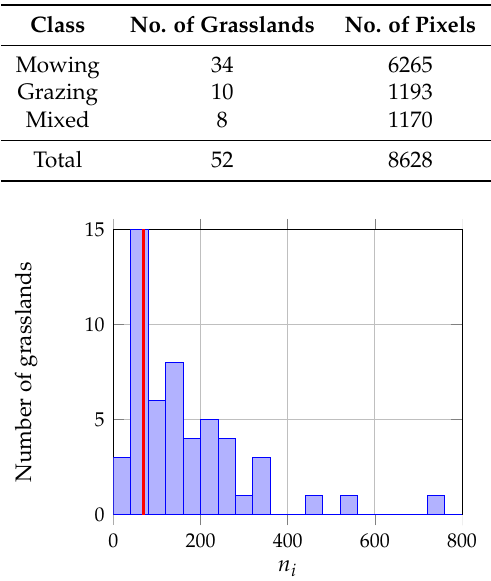
Figure 6. Histogram of grasslands’ size in the number of pixels n i . The red line corresponds to the number of spectro-variables d = 68 in